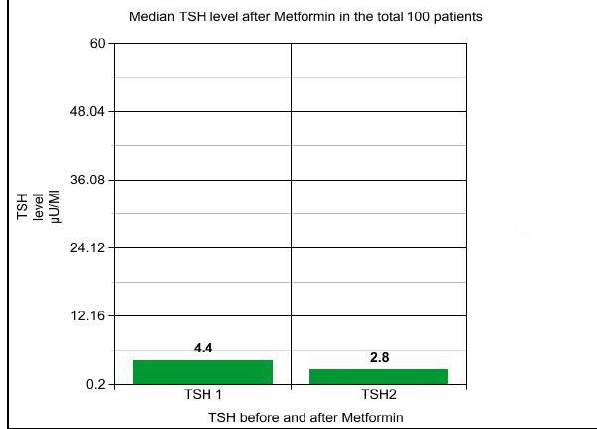
Figure 1: shows median TSH status after metformin in the total 100 patients. TSH 1 indicates initial TSH and TSH 2 indicate level after